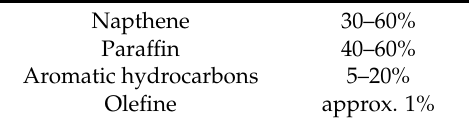
Table 1. Ingredients of mineral oil